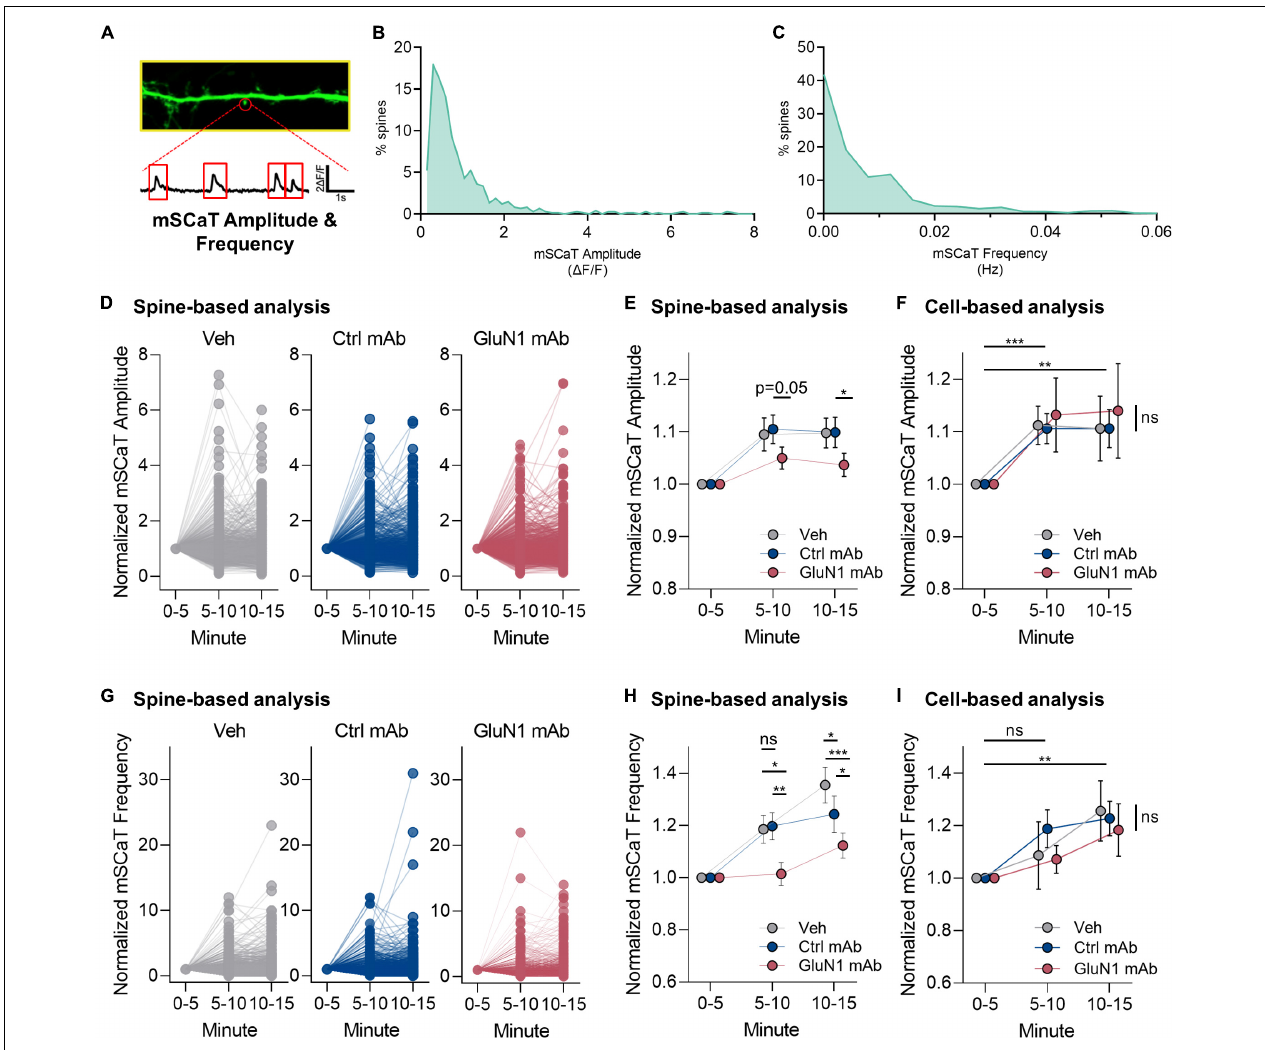
FIGURE 4 | Human GluN1 mAbs have limited effect on NMDAR-dependent miniature spontaneous Ca 2 + transients (mSCaTs). (A) Zoom in of dendrite of hippocampal cell transduced with GCaMP6f (green). Spine identified by red circle. Below, (cid:49) F/F trace of spine region identified in panel (A) plotted against time. Red box indicates regions analyzed as mSCaTs. (B) Frequency histogram of mSCaT amplitude ( (cid:49) F/F) for individual synapses across 747 spines from 7 cells in vehicle condition. (C) Frequency histogram of mSCaT frequency (Hz) for individual synapses across 747 spines from 7 cells in vehicle condition. (D) Dot plots of normalized mSCaT amplitude in individual treatments over time. Vehicle or mAb added after 5 min baseline. (E) Normalized mSCaT amplitude over recording on per spine basis. A two-way ANOVA was performed to analyze the effect of mAb and time on mSCaT amplitude. Compared to the control mAb, GluN1 mAb from a patient with anti-NMDAR encephalitis showed a small decrease in Ca 2 + influx through NMDARs activated by spontaneous glutamate release (spontaneous release) after 10 min exposure. (F) Normalized mSCaT amplitude over recording session (mean ± SEM for each group; n = 6–7 cells). A two-way ANOVA was performed to analyze the effect of mAb and time on mSCaT amplitude on per cell basis. There was no statistically significant interaction between the effects of mAb and time [ F (4, 32) = 0.07, p = 1.0]. Simple main effects analysis showed that mAb did not have a statistically significant effect on mSCaT amplitude ( p = 0.9). Simple main effects analysis showed that time did have a statistically significant effect on mSCaT frequency ( p = 0.001). Both timepoints were significantly increased from baseline using Dunnett’s multiple comparisons test (5–10 min, p = 0.0006; 10–15 min, p = 0.009). (G) Dot plots of normalized mSCaT frequency in individual treatments over time. Vehicle or mAb added after 5 min baseline. (H) Normalized mSCaT frequency over recording session. A one-way ANOVA was performed to analyze the effect of mAb on mSCaT frequency at 5–10 min [ F (2, 2,575) = 4.8, p = 0.009] and 10–15 min [ F (2, 2,575) = 12, p ≤ 0.0001] timepoints. Unexpectedly, there was a significant reduction in the mSCaT frequency observed with GluN1 mAb compared to control mAb at 5–10 min ( p = 0.007, Fisher’s LSD) and 10–15 min ( p = 0.01, Fisher’s LSD) timepoints. This effect was significant also observed comparing GluN1 mAb to vehicle at 1–5 min ( p = 0.01, Fisher’s LSD) and 5–10 min ( p < 0.0001) exposure time. The control mAb had no effect compared to vehicle at 5–10 min ( p > 0.05, Fisher’s LSD), but reduced mSCaT frequency at 10–15 min compared to vehicle ( p = 0.03, Fisher’s LSD). (I) Normalized mSCaT frequency over recording session (mean ± SEM for each group; n = 6–7 cells). A two-way ANOVA was performed to analyze the effect of mAb and time on mSCaT frequency. There was no statistically significant interaction between the effects of mAb and time [ F (4, 32) = 0.38, p = 0.8]. Simple main effects analysis showed that mAb did not have a statistically significant effect on mSCaT frequency ( p = 0.8). Simple main effects analysis showed that time did have a statistically significant effect on mSCaT frequency ( p = 0.0012). Post-hoc Dunnett’s multiple comparisons test revealed mSCaT frequency at 10–15 min was significantly different from baseline ( p = 0.0012). Ctrl, control; mAb, human monoclonal antibody; ns, not significant; Veh,